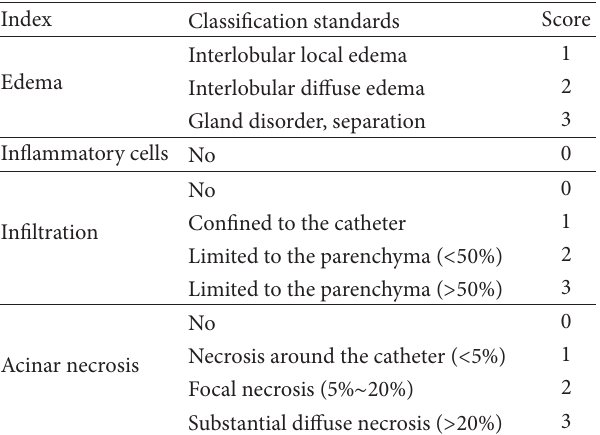
Table 1: Pathological score